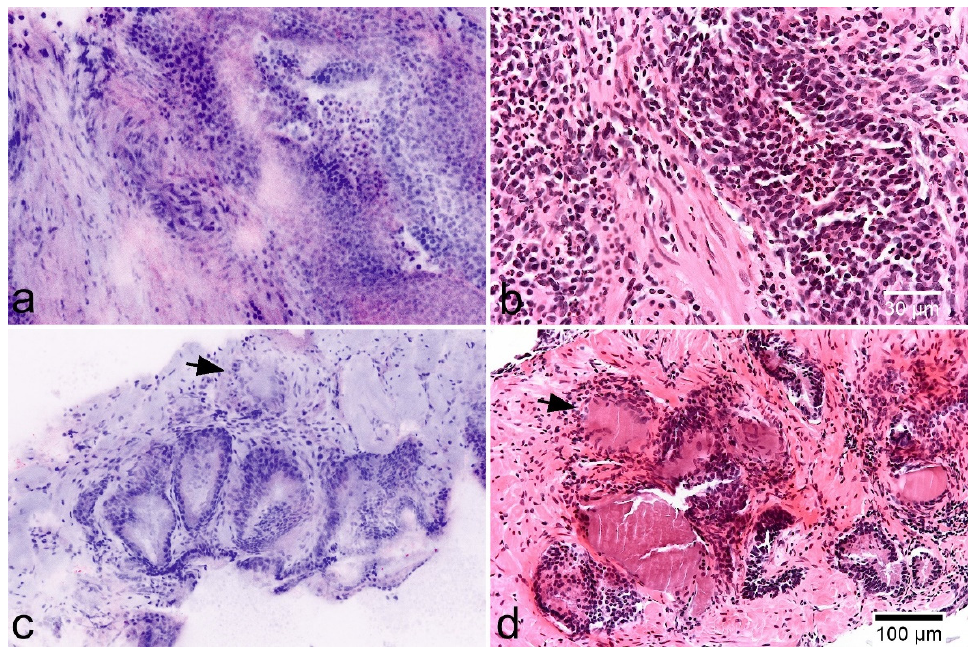
Figure 6. Inflammatory lesions of the prostate. ( a , b ) Acute prostatitis in FCM scans (left) and HE- morphology. Note a dense granulocytic infiltrate in the stroma and epithelium. ( c , d ) Non-specific granulomatous prostatitis showing enlarged glands and a periglandular inflammatory infiltrate of lymphocytes and giant cells (arrows).